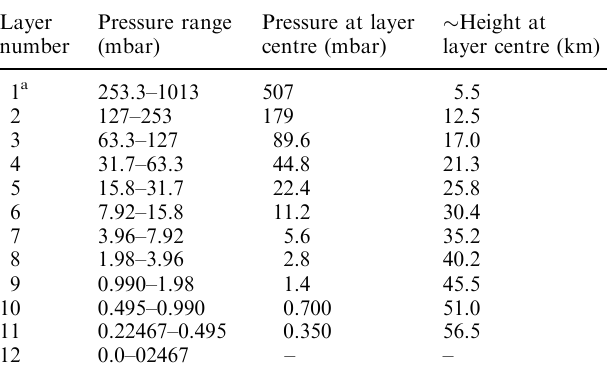
Table 1. Umkehr layers used for ozone profile retrievals with SBUV Layer Pressure range number